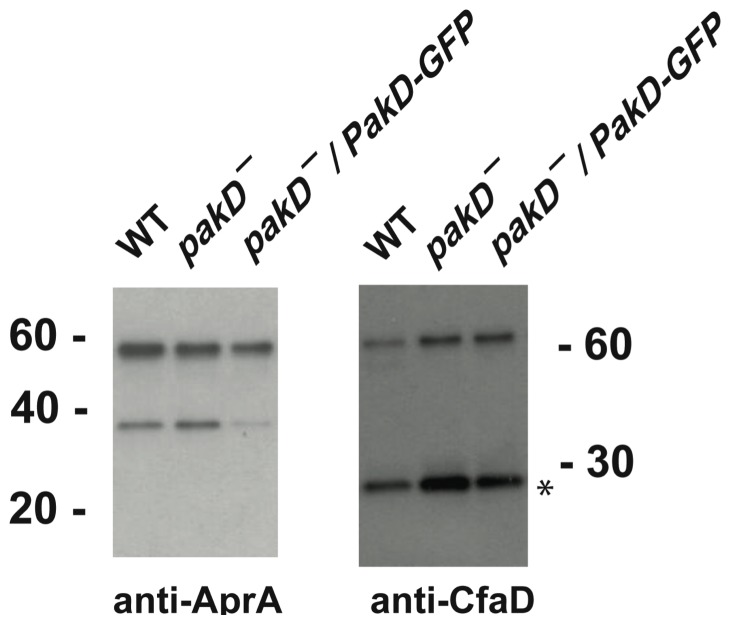

pakD– cells accumulate extracellular AprA and CfaD.Conditioned media from cells at 1×107 cells/ml was collected and stained for AprA and CfaD by Western blots. The asterisk indicates a 27-kDa breakdown product of CfaD. The non-specific band at 35 kDa in the AprA blot varied in intensity between experiments and between genotypes.